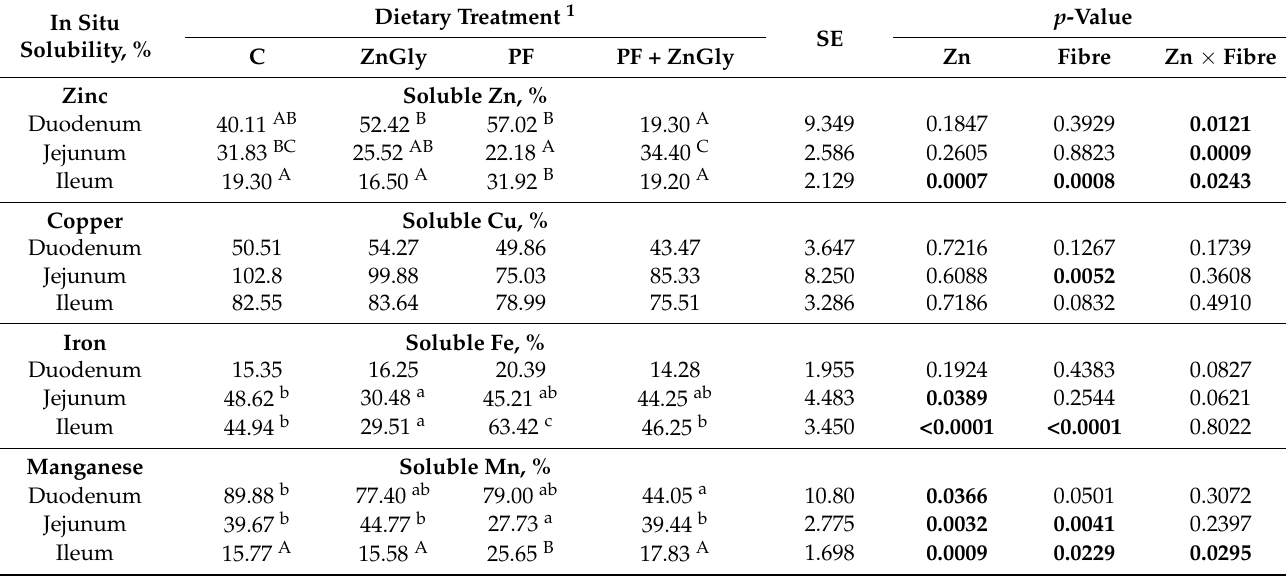
Table 3. In situ soluble content of Zn, Cu, Fe and Mn from intestinal digesta after dietary treatments with Zn and fibre from different sources.